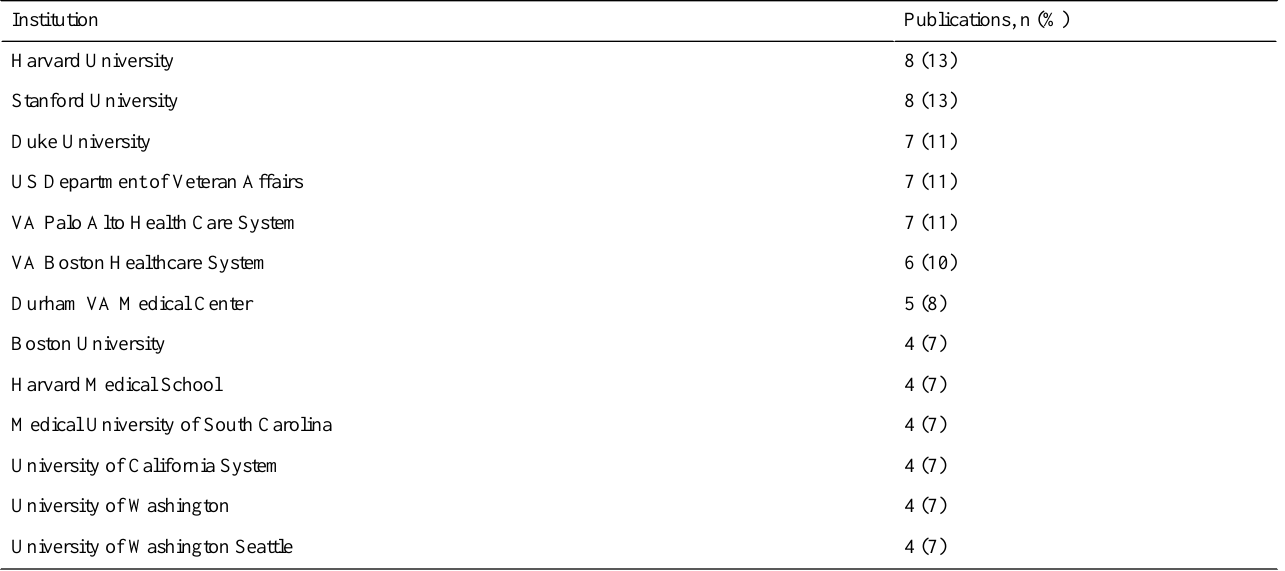
Table 4. Institutions with the greatest contributions to the field (N=156).